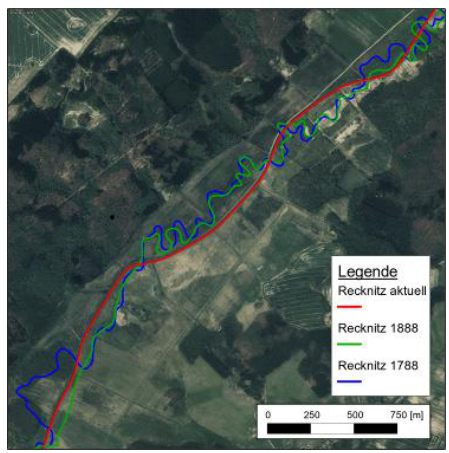
Figure 9. Water course changes of the river